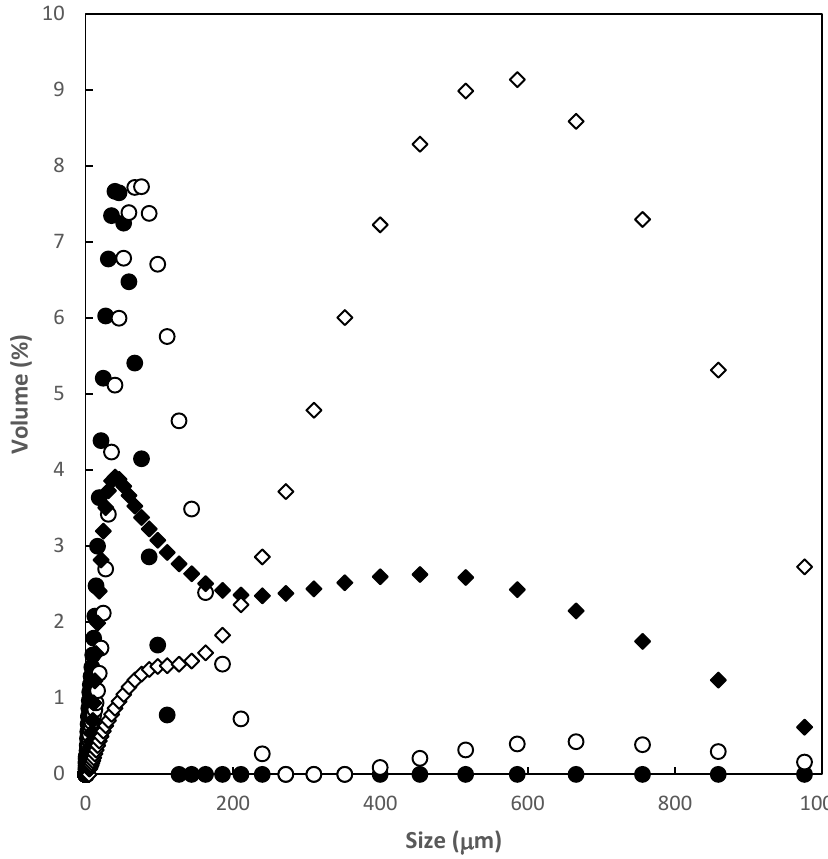
Figure 3. Particle size distribution (γ–CDs (•), HP–γ–CDs ( ○ ), γ–CDs-EPI ( ♦ ), HP–γ–CDs-EPI ( ⟡ )).